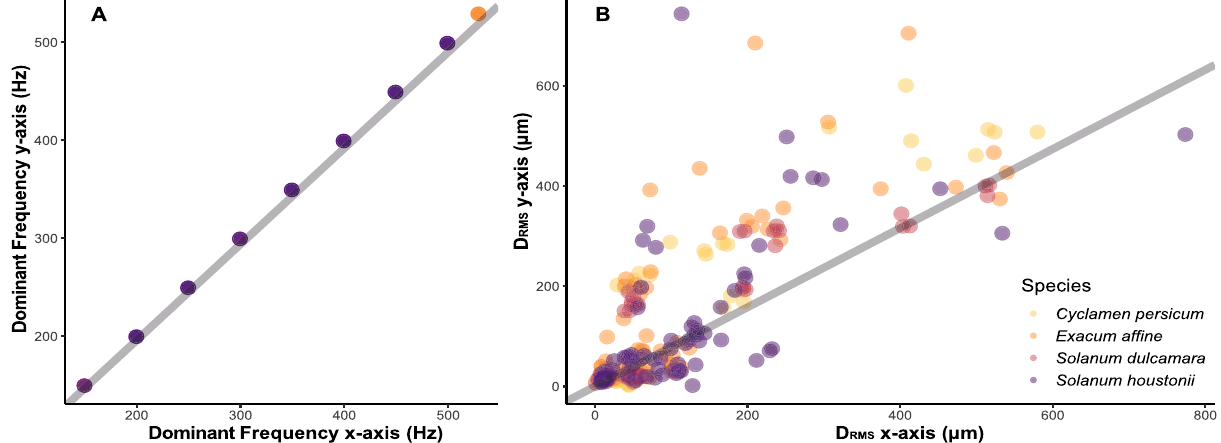
Figure 2. Measurement of ( A ) frequency (dominant frequency, Hz) and ( B ) root mean square amplitude (D RMS , μm) in either the x- or y-axis. Grey lines indicate 1:1 relationship. Estimate Std. error p -value* p